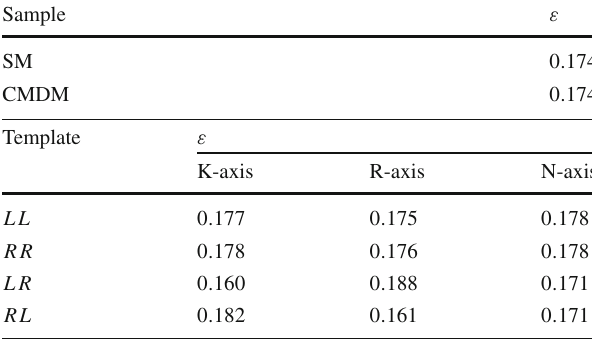
Table 2 Efficiencies for the samples and templates considered in this work. An uncertainty better than 0 . 001 is evaluated, for all efficiencies